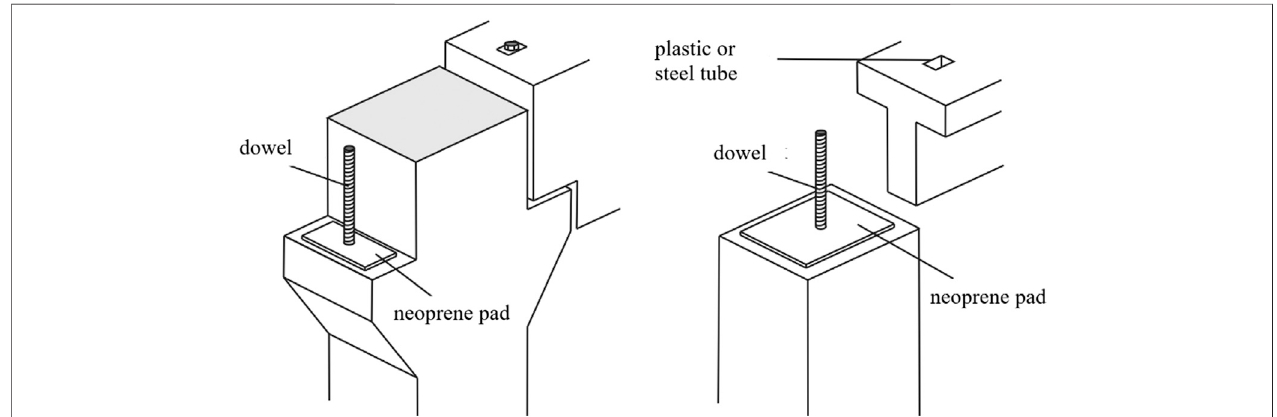
FIGURE 1 | Assembly schemes of typical beam-column dowel